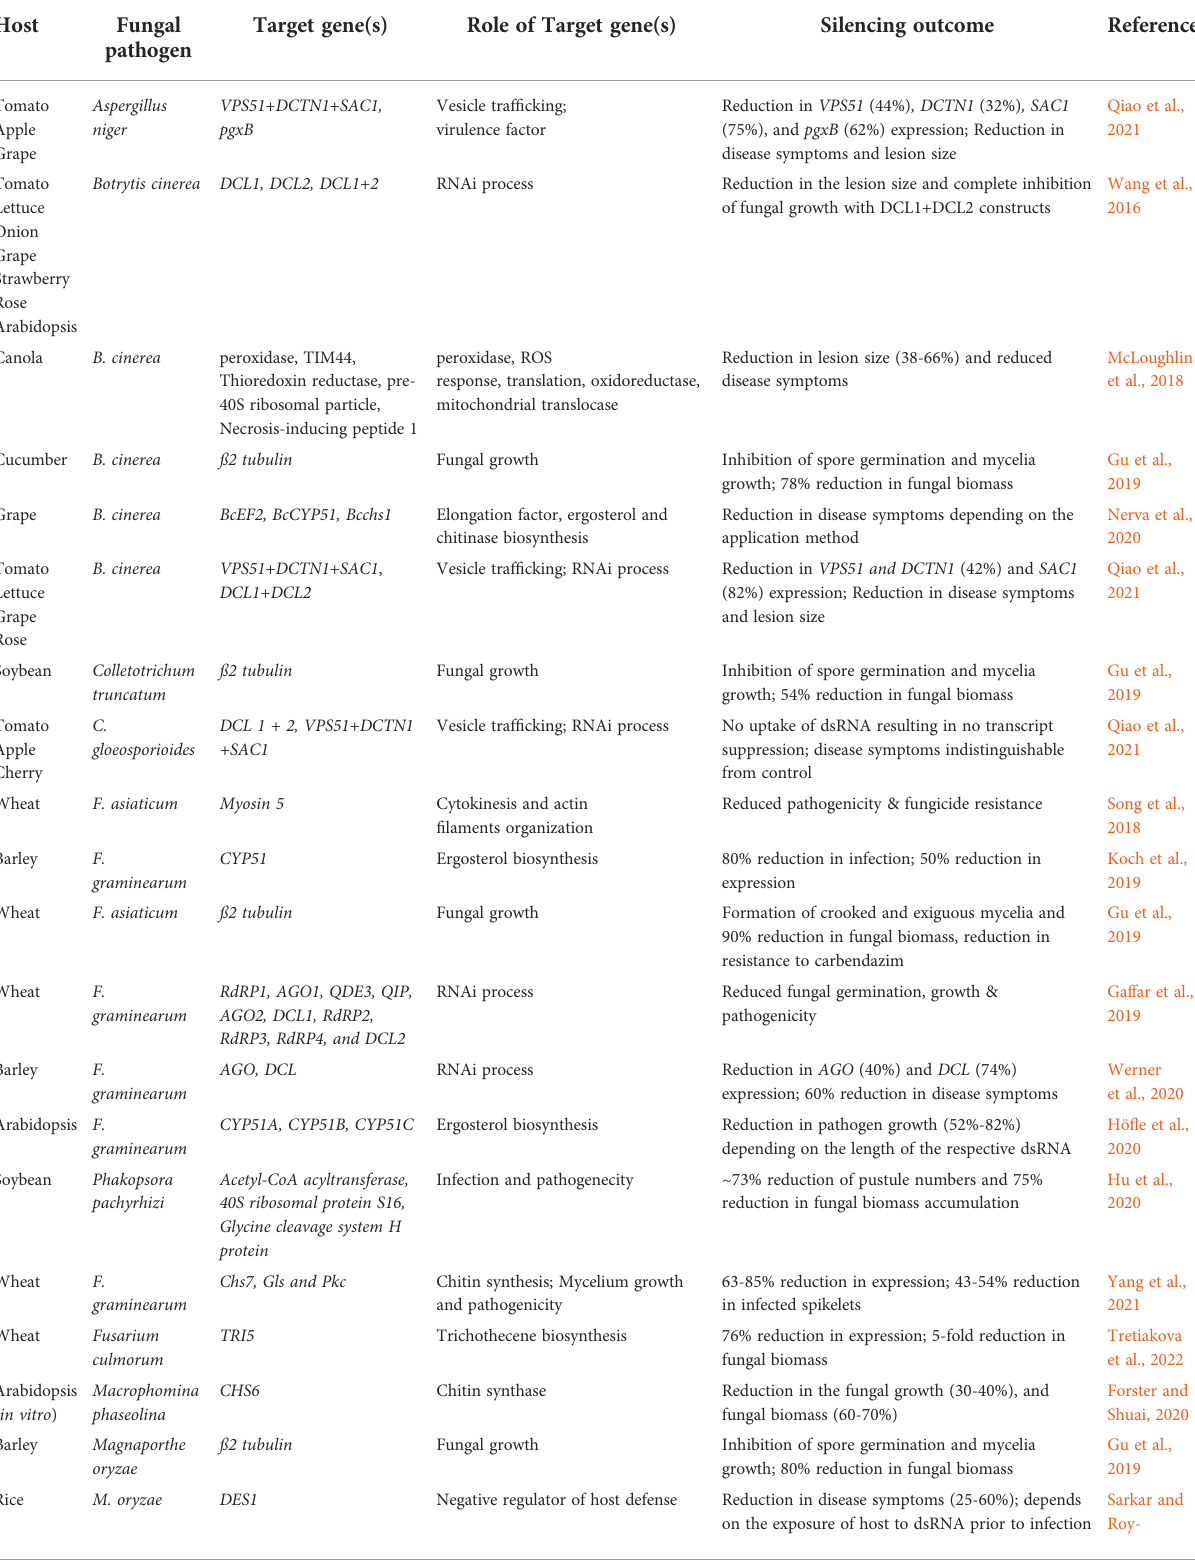
TABLE 2 List of phytopathogenic fungal genes targeted through Spray-Induced Gene Silencing